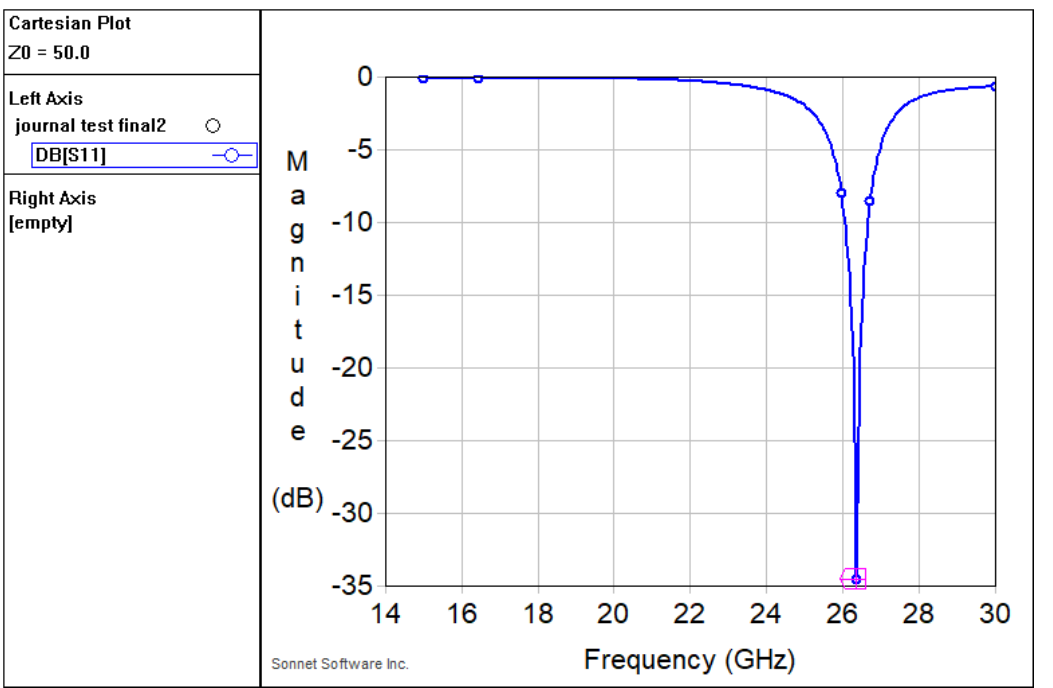
Figure 2. Output signal of the slitted inset fed butterfly-shaped microstrip patch antenna